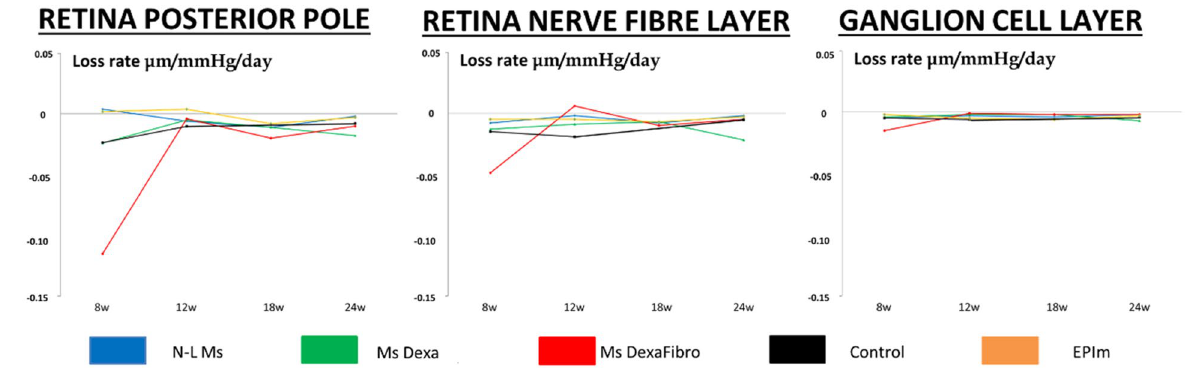
Figure 5. Standardization of neuroretinal thickness loss measured using optical coherence tomography between four chronic glaucoma models and healthy control cohorts. w week; N-L Ms cohort with non-loaded microspheres; MsDexa cohort with microspheres loaded with dexamethasone; MsDexaFibro cohort with microspheres loaded with dexamethasone and fibronectin; EPIm cohort with sclerosis of the episcleral